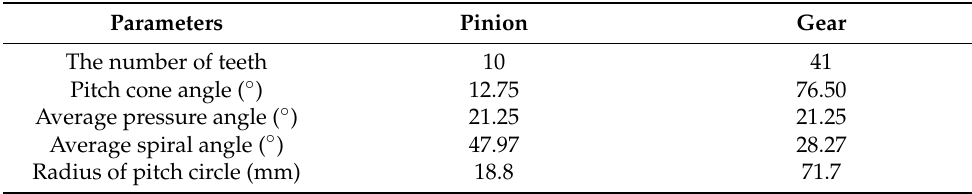
Table 2. Parameters of the main